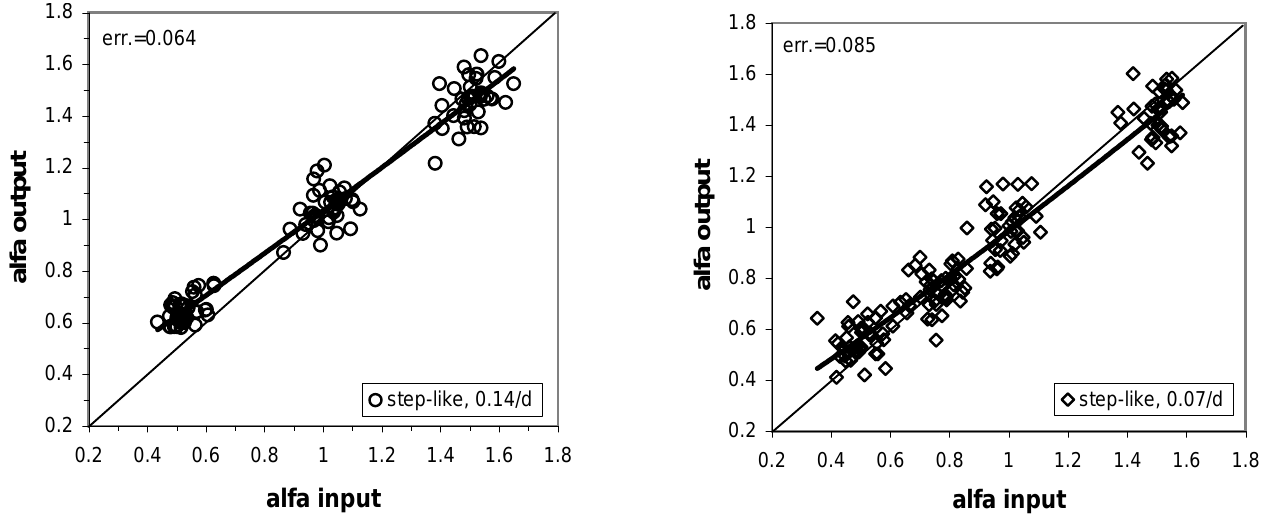
Fig. 5. DFA-calculated vs. expected α exponents for RSS. All the simulated series having known α exponent were step-like interpolated,